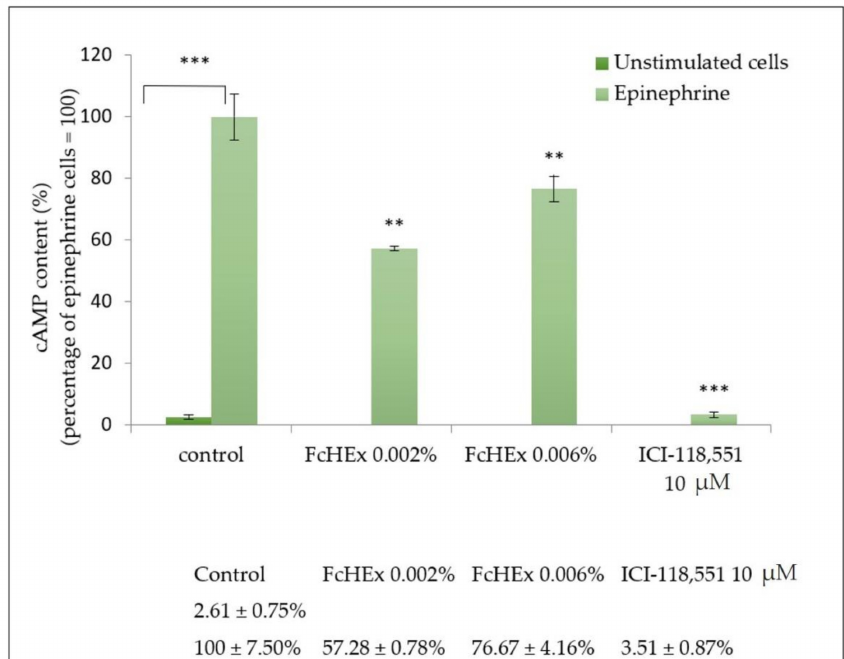
Figure 1. Effect of the Ficus carica cell suspension culture extract (FcHEx) on the cAMP synthesis in skin keratinocytes. The keratinocytes were stimulated with 10 µ M of epinephrine alone or with the FcHEx or with a positive control for 30 min and then processed to determine the cAMP content. The reported values represent the averages of three independent experiments and are expressed as the percentages of cells treated with epinephrine only, which was set to 100%. The asterisks indicate statistically significant values (*** p -value was between 0.0001 and 0.001; ** p -value was between 0.001 and 0.01).